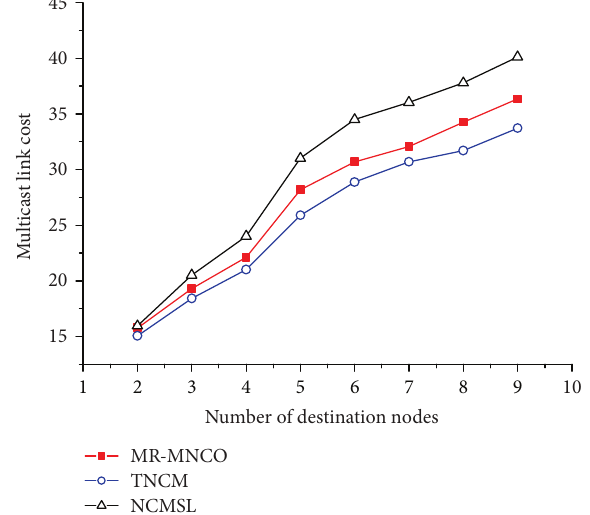
Figure 5: Multicast link cost versus number of destination nodes.